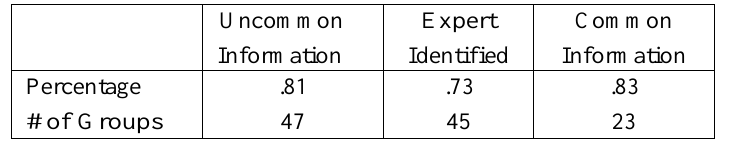
Table 4: Percentage of Groups Choosing Payoff Maximizing Option